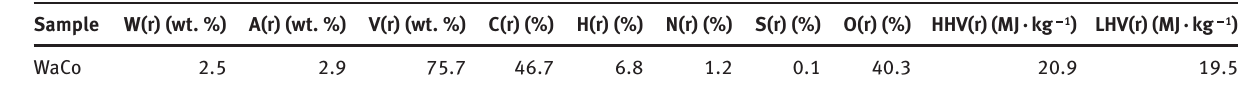
Table 1: Proximate and ultimate analysis.